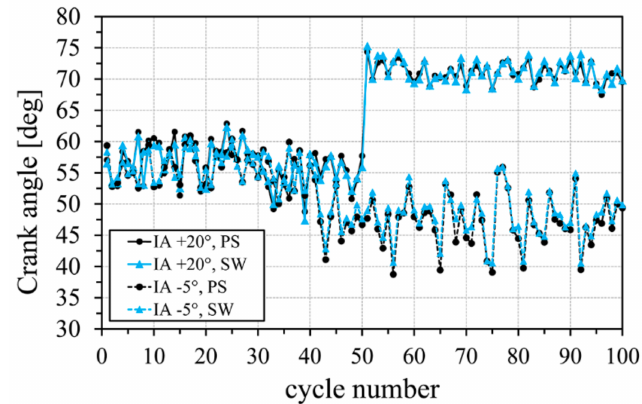
Figure 16. Maximum in-cylinder pressure on 100 consecutive cycles evaluated by the pressure sensor and the strain washer by increasing the ignition advance of 20 CA deg (dashed line) and reducing it of 5 CA deg (solid line) at 4000 rpm and full load.